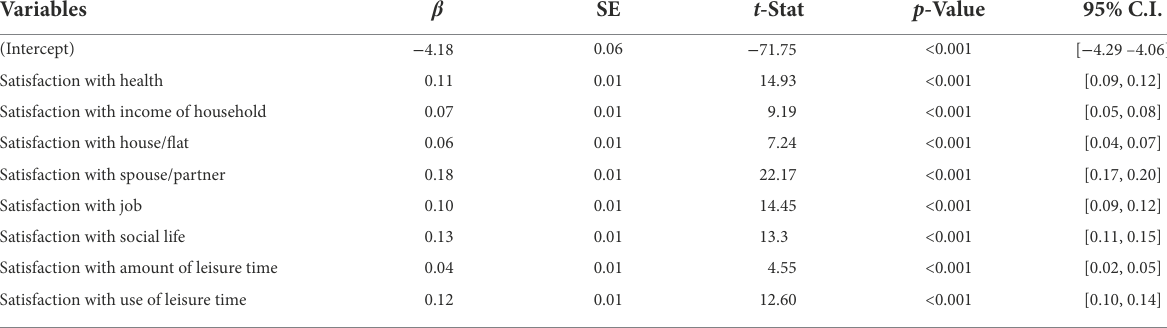
TABLE 3 Multiple regression analysis results for areas of life satisfaction and overall satisfaction after factoring out demographics. Variables